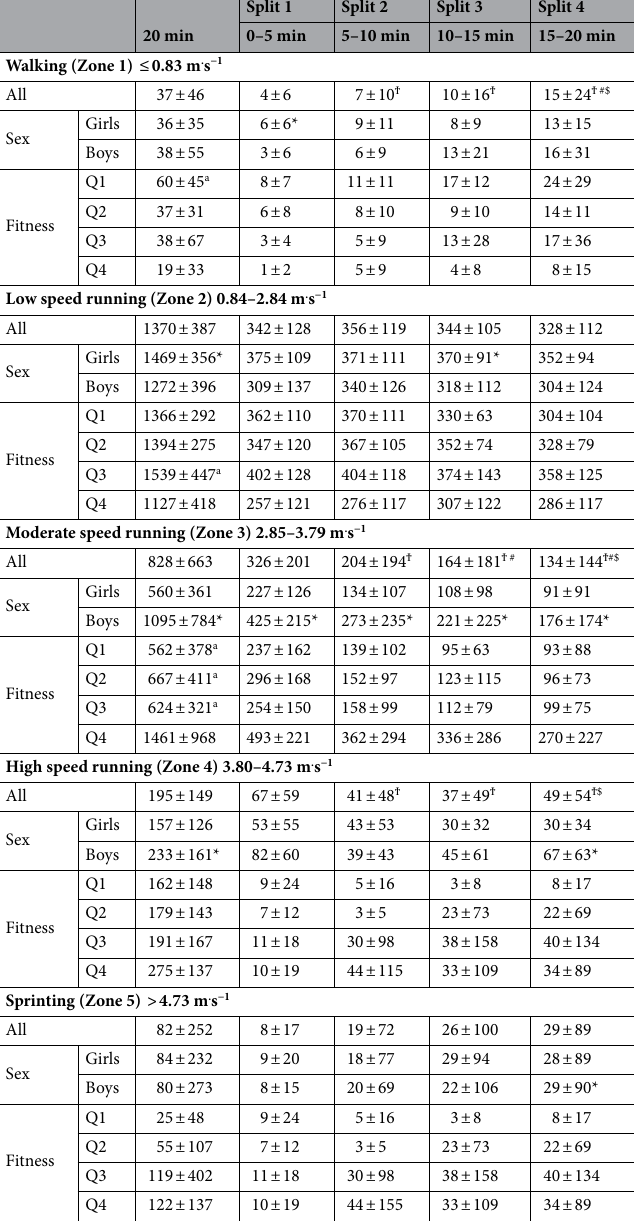
Table 3. Distance covered (m) by participants in each speed zone during The Daily Mile. Q quartile. Ϯ Denotes significant difference ( p ≤ 0.05) from Split 1. # Denotes a significant difference from Split 2. $ Denotes a significant difference from Split 3. *Indicates the sex that covered a significantly greater distance during the specified time frame. a Represents a significant difference from quartile 4